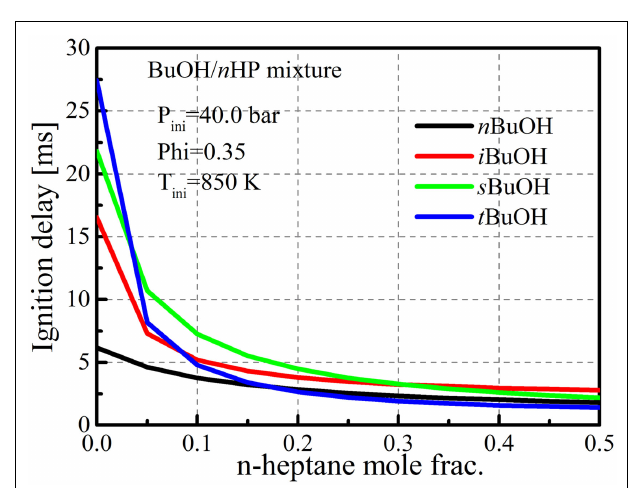
FIGURE 8 | Comparisons of CA50 timings and n -heptane blending ratios to maintain similar CA50 among the butanol isomers . FIGURE 9 | Ignition delays as function of n -heptane blending ratio for